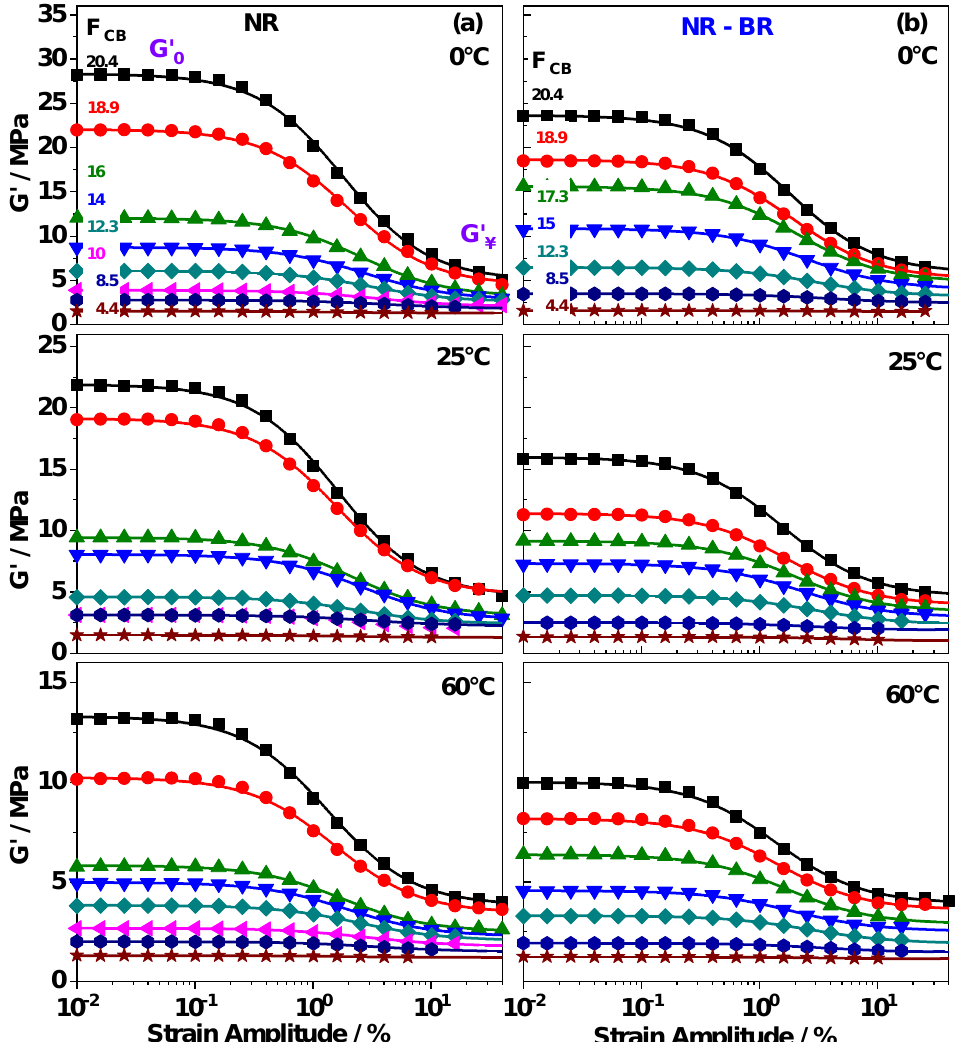
Figure 1. Dynamic storage modulus G (cid:48) as a function of shear strain amplitude γ for ( a ) NR and ( b ) NR-BR composites containing varied fractions of carbon black Φ CB (volume fractions are labeled in the upper plot). All measurements are done at 10 rad/s and temperatures of 0 ◦ C, 25 ◦ C and 60 ◦ C. The lines are fits based on the Kraus Equation (Equation (1)). The obtained ∆ G (cid:48) values are given in Table 1. Experimental uncertainties of the mechanical measurements are of the order of symbol size. In order to quantify the filler network contributions to reinforcement the G (cid:48) ( γ )